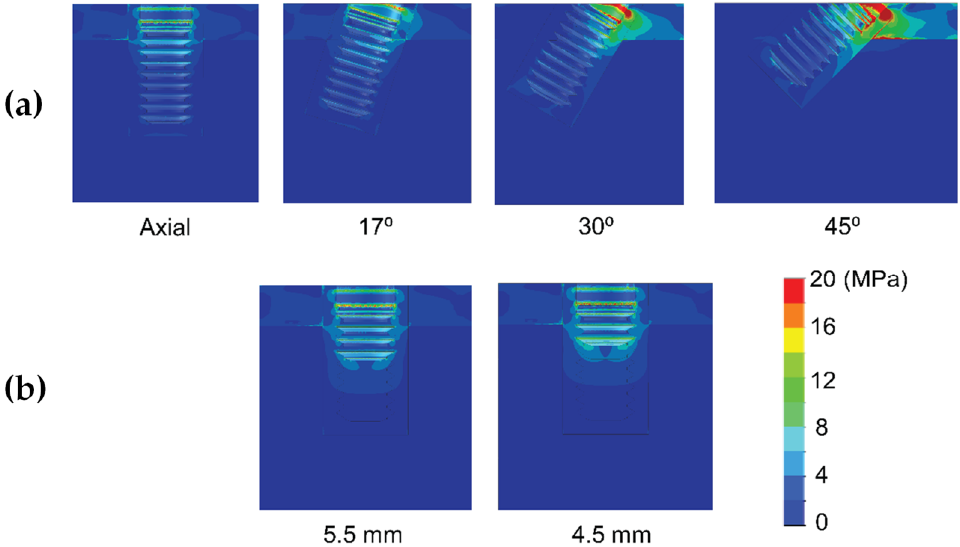
Figure 5. Von Mises stress distribution of immediately-loaded long 10 mm implant ( a ) and short implants (4.5 and 5.5 mm in length) ( b ) in bone type II.